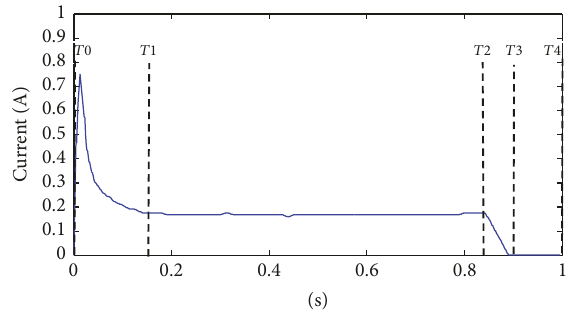
Figure 2: The turnout operation current curve.